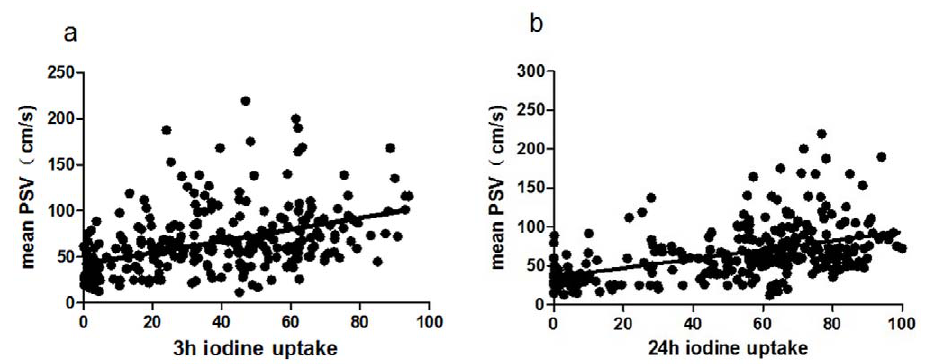
Figure 1. Correlations of mean STA-PSV with 3 h and 24 h RAIU.